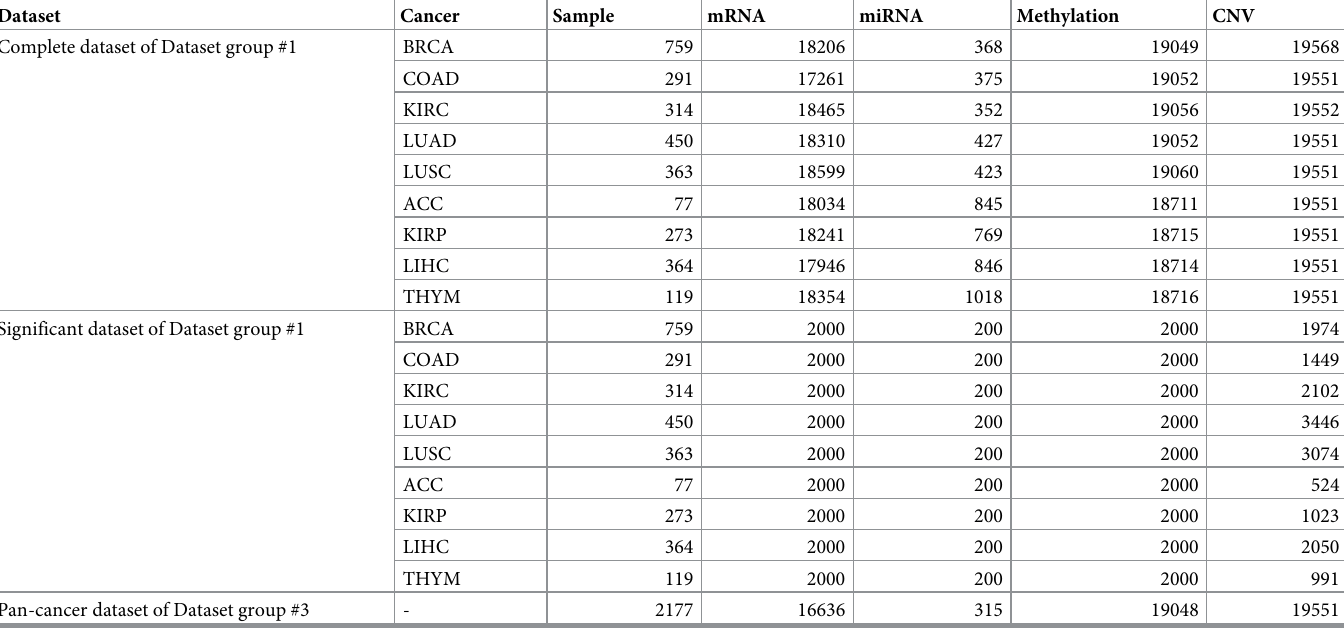
Table 4. Data scales of different